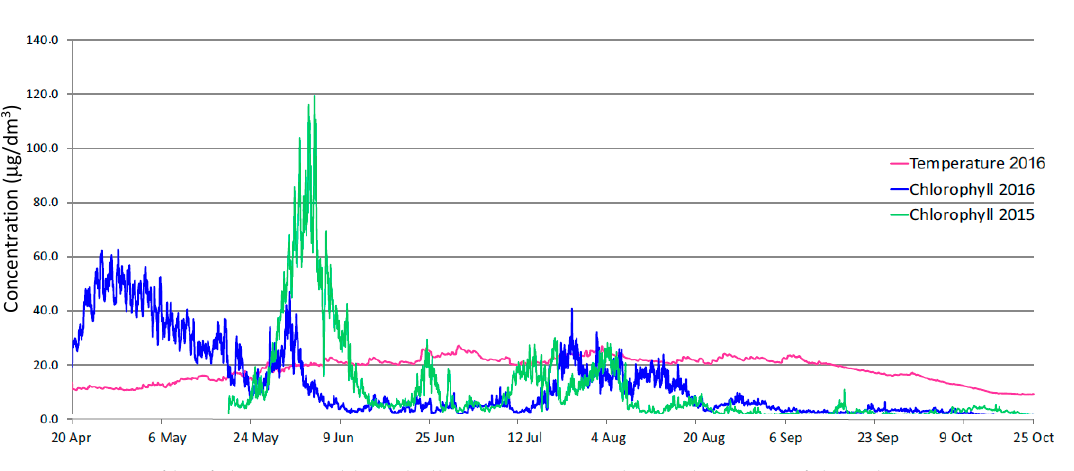
Figure 6. Profile of changes in chlorophyll concentration in the northern part of the Sulejow Reservoir in the period April–October in 2015 and 2016 (chlorophyll concentration in µ g/dm 3 , water temperature in °C).